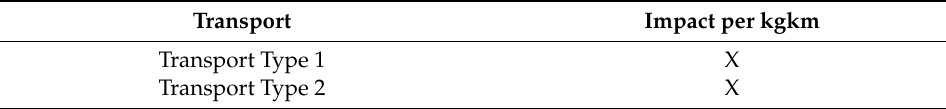
Table 2. Environmental impact of transports.